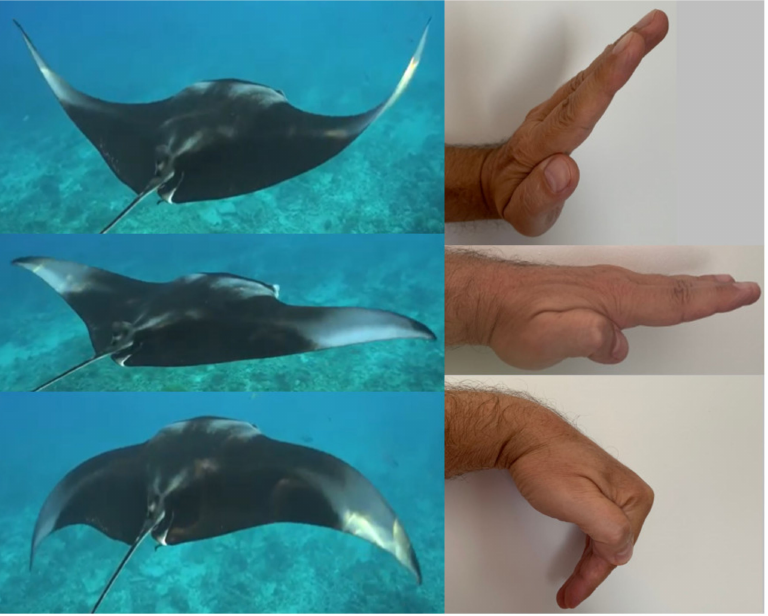
Figure 4. Emphasizing the similarity of manta ray fins and human palm